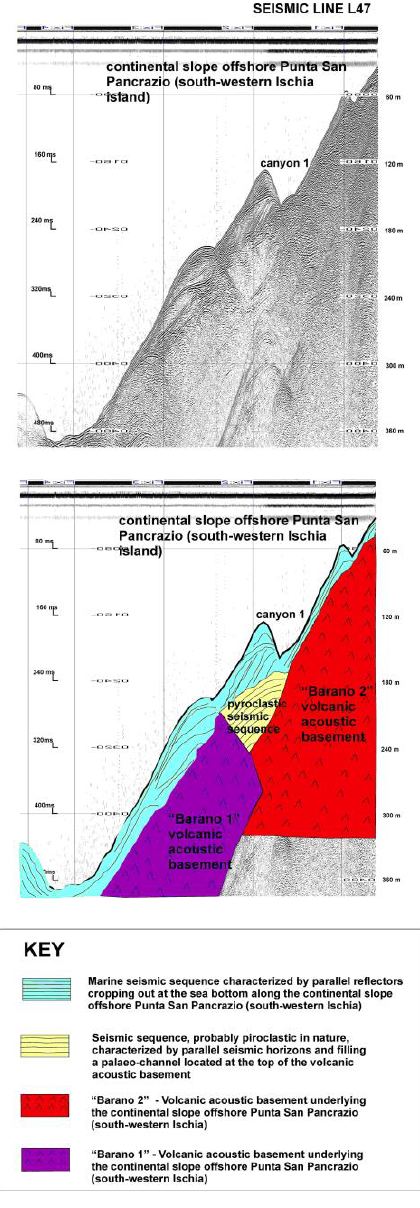
Figure 9. Seismic profile L47 (southern Ischia, Punta S. Pancrazio) and corresponding geologic in- terpretation.